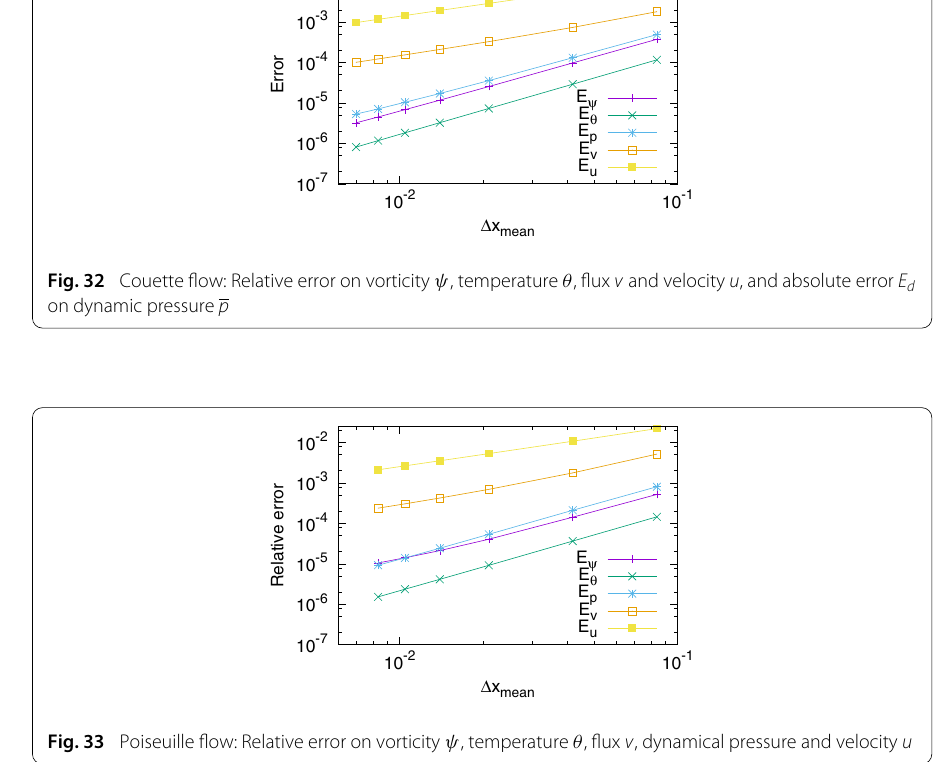
As a consequence, the incompressibility condition (152b) is verified exactly, as well localy as